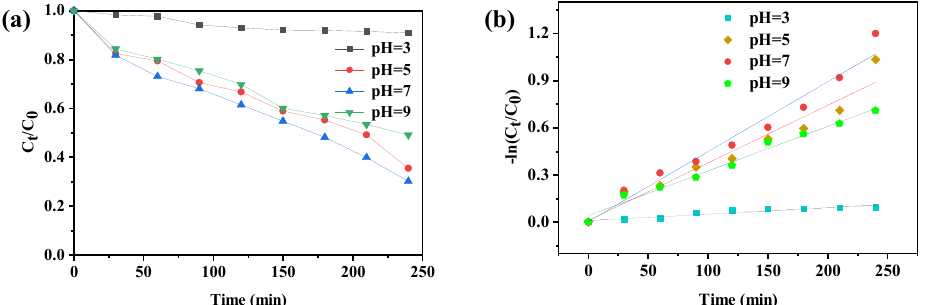
Figure 7. ( a ) Degradation rate of compound 1 to ciprofloxacin under different pH conditions, ( b ) Quasi-first order kinetic reaction rate at different pH values.